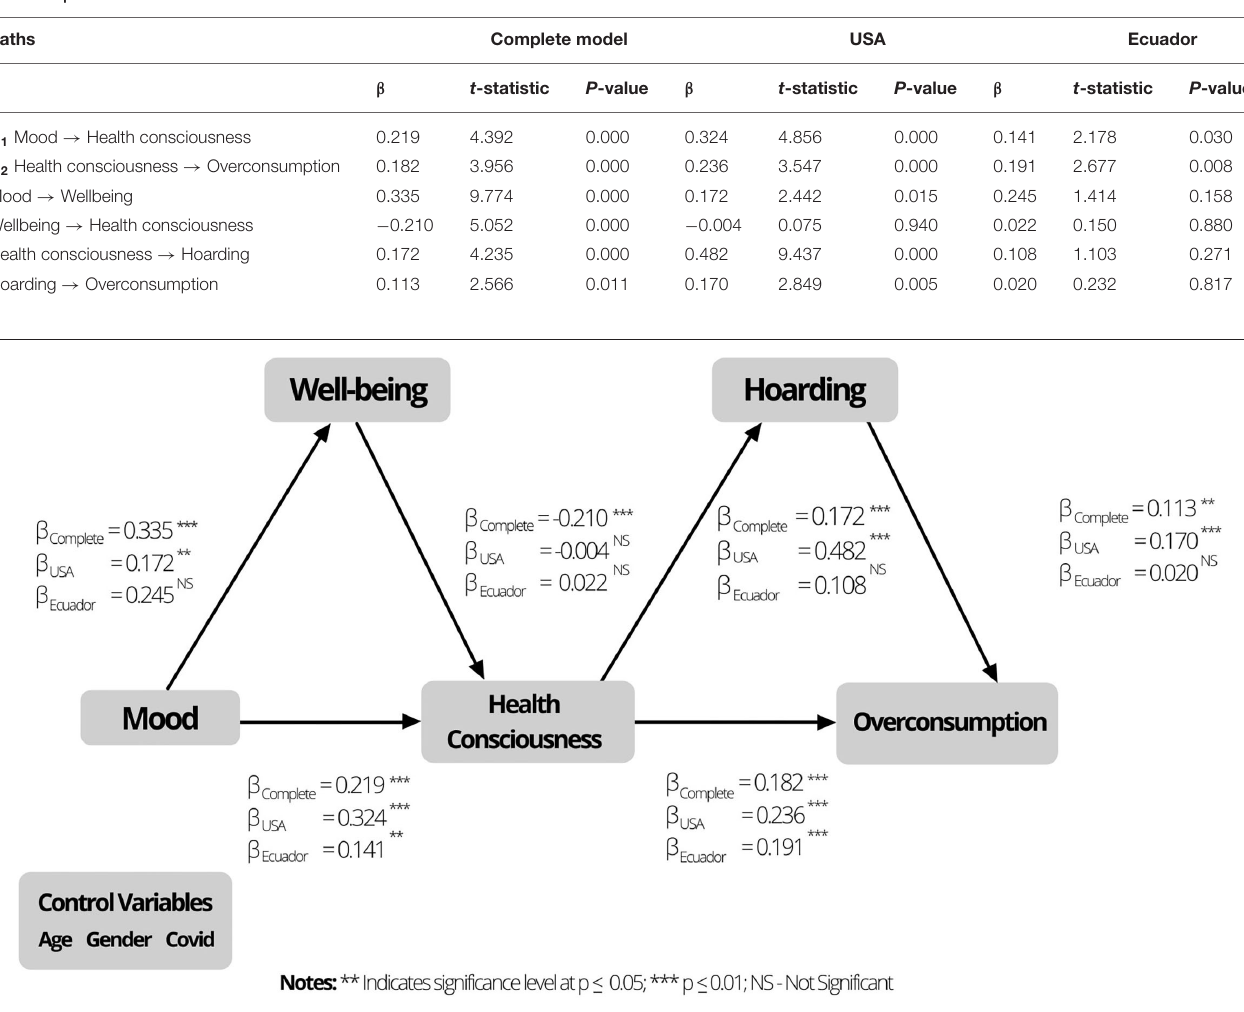
TABLE 4 | Path coefficients.